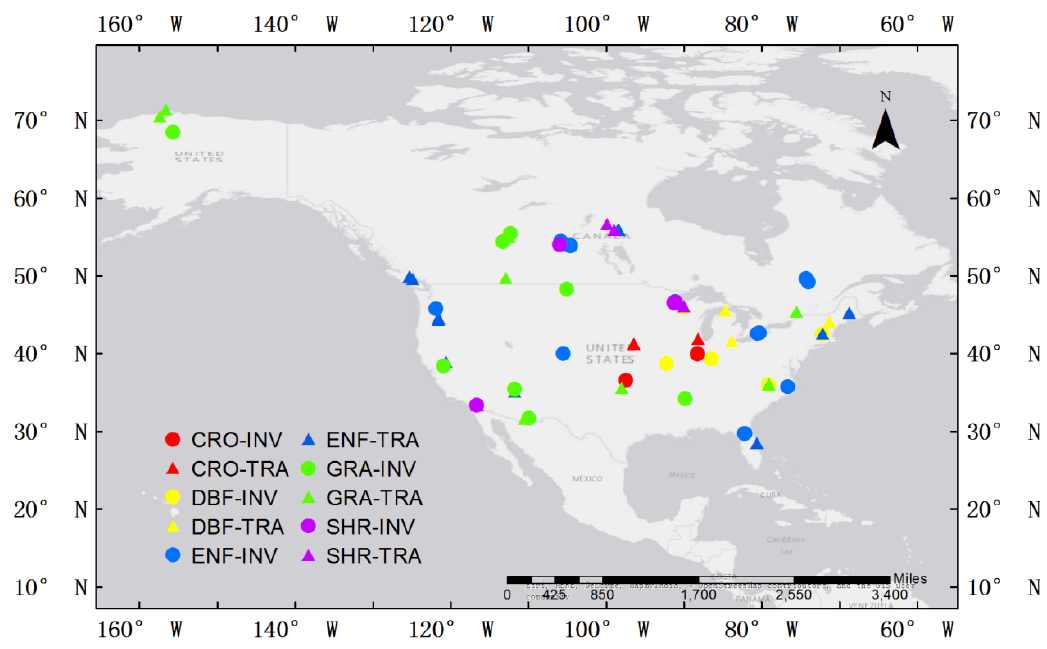
Figure 4. Location of the 85 eddy covariance flux towers used in this study. INV means the data of this site were used to inverse, TRA means that the data of this site were used for training.